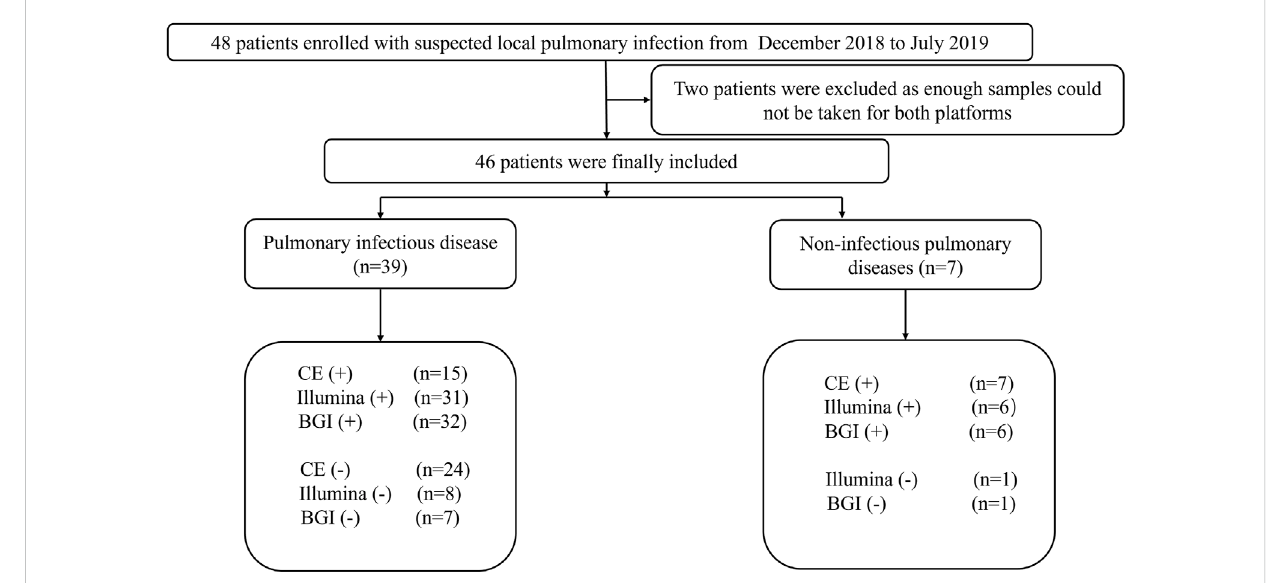
FIGURE 1 Flow chart depicting the enrollment of patients in this study. CE, conventional examination; BGI, Beijing Genomics